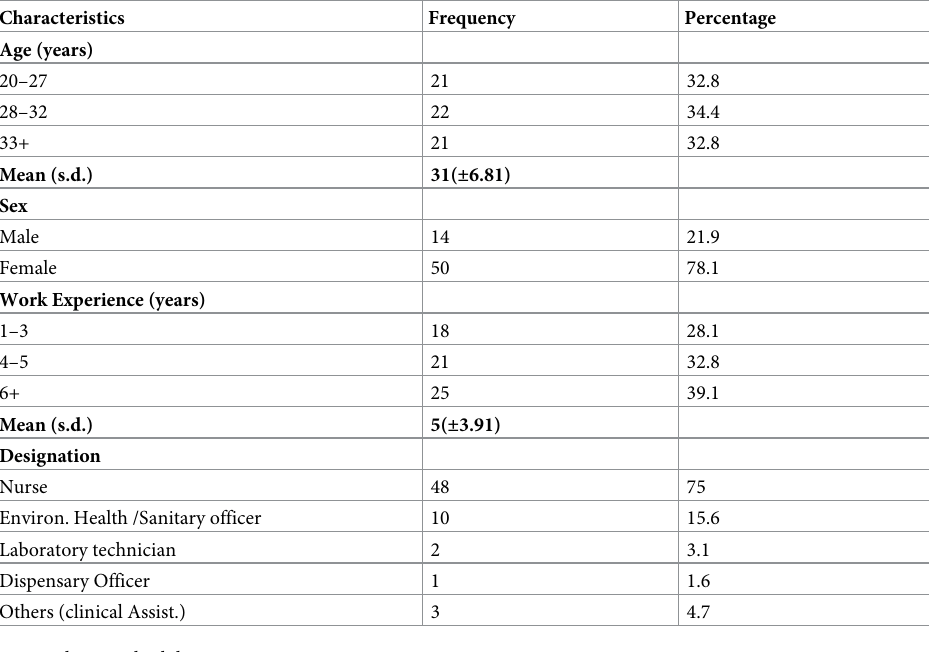
Table 1. Demographic characteristics of healthcare